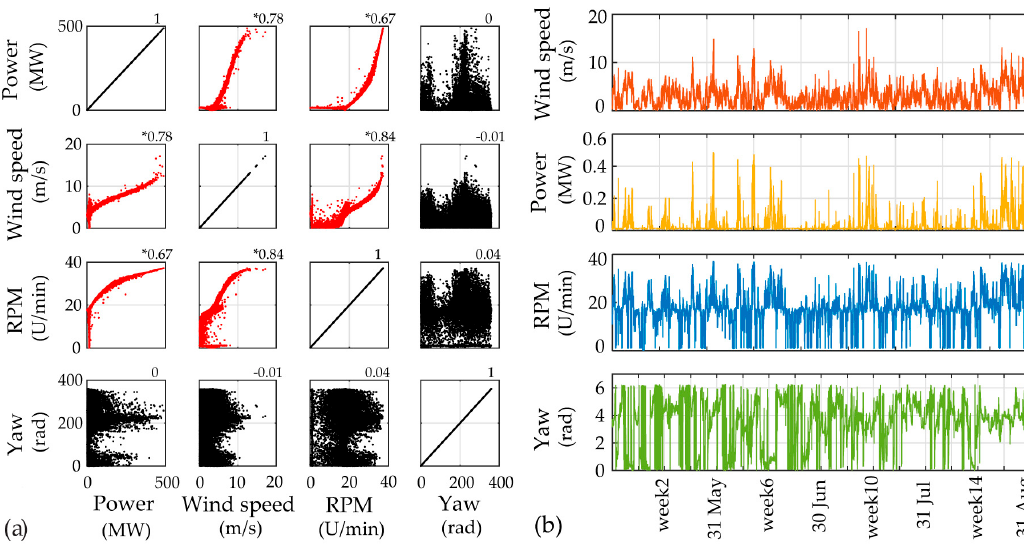
Figure 14. ( a ) Scatter plots of selected PCE input variables and estimated correlation values; ( b ) Time history plots of the selected PCE input variables for 17 706 datasets (Case B).